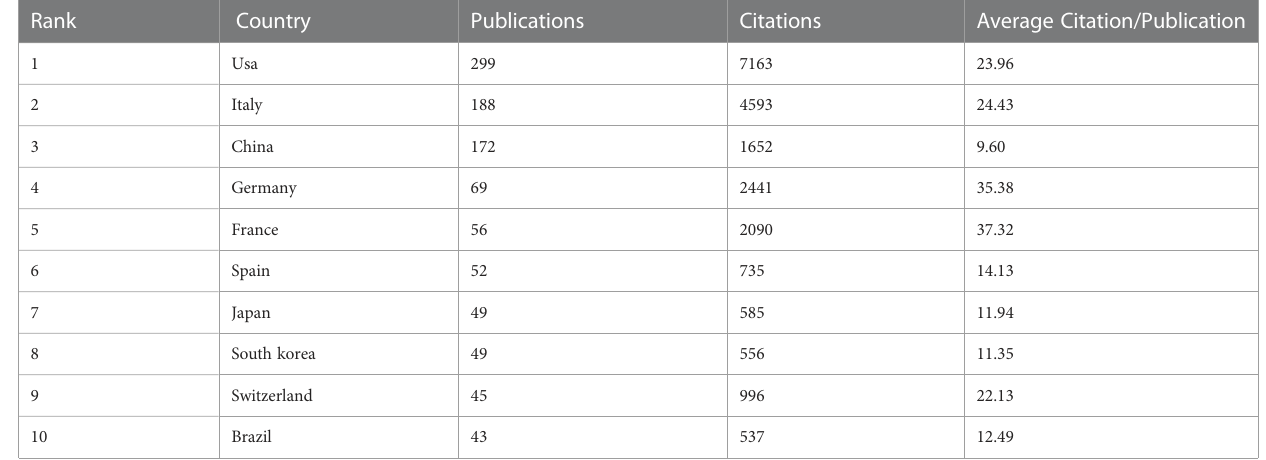
TABLE 1 Top 10 countries in the MTC research fi eld.